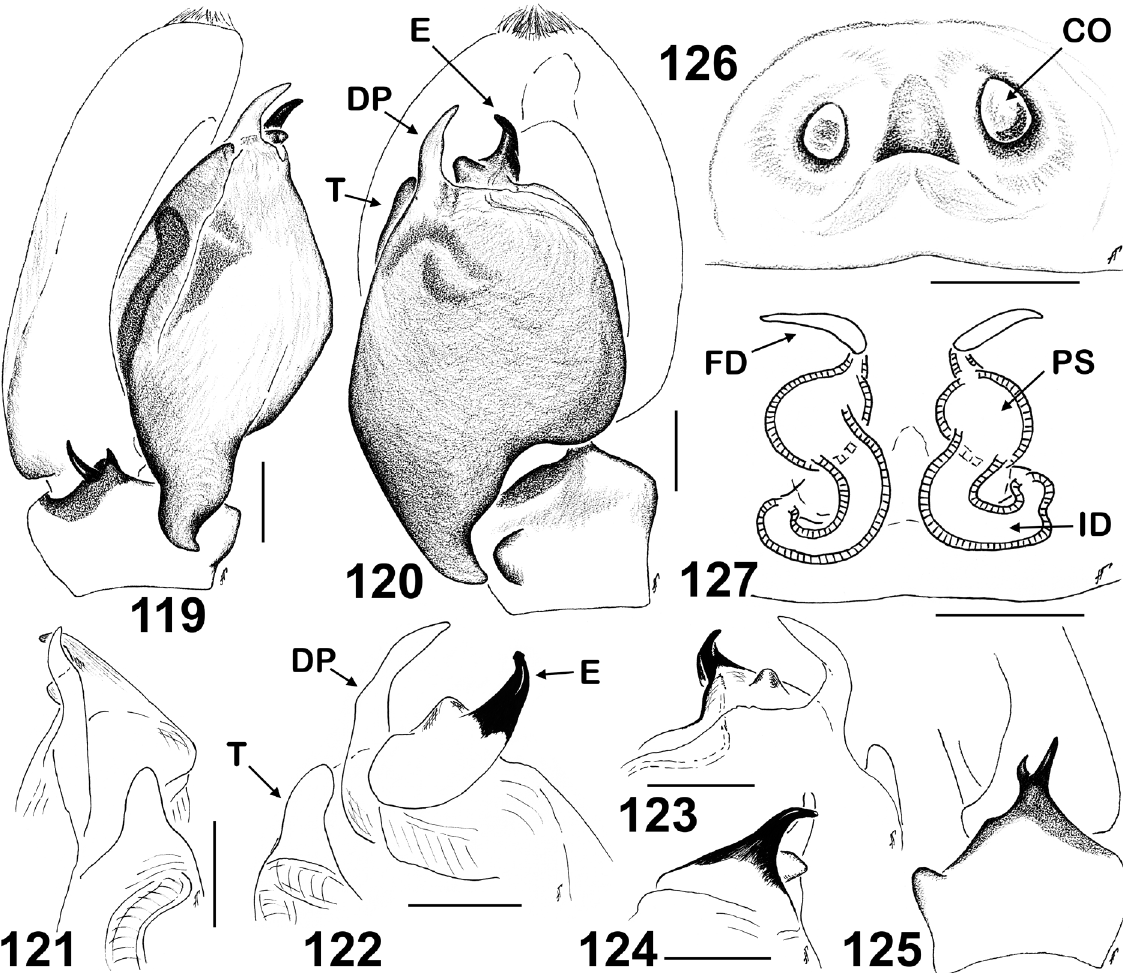
Figs 119–127. Stenaelurillus furcatus Wesołowska, 2014 from Namibia (Etosha National Park; MRAC 215.642). 119 . Male palp, retrolateral view. 120 . Male palp, ventral view. 121–124 . Embolic division. 121 . Retrolateral view. 122 . Dorsal view. 123 . Ventral view. 124 . Median view. 125 . RTA, retrolateral view. 126 . Epigyne, ventral view. 127 . Spermathecae, dorsal view. Abbreviations: see Material and methods. Scale bars: 0.1